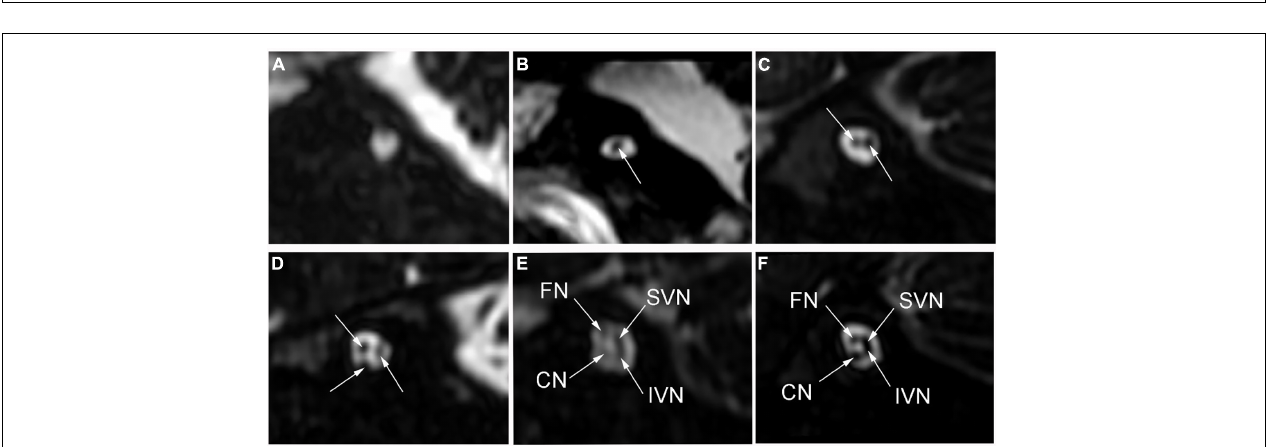
FIGURE 1 | (A) Measurement of the bony cochlear nerve canal diameter using high-resolution computed tomography (distance between the two black arrows). (B) Measurement of the internal auditory canal diameter using high-resolution computed tomography (distance between the two black arrows). (C) Measurement of the area ratio of the vestibulocochlear nerve to the facial nerve at the cerebellopontine angle using magnetic resonance imaging (black arrows).